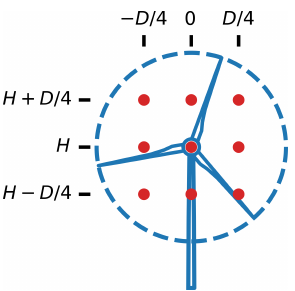
Figure 1. The nine locations at which the wind speeds are calcu- lated across a wind turbine rotor. D represents the rotor diameter, while H is the turbine hub height. The effective turbine wind speed is determined as the average of the wind speed at each of these points. Table 1. Wind turbine parameters.